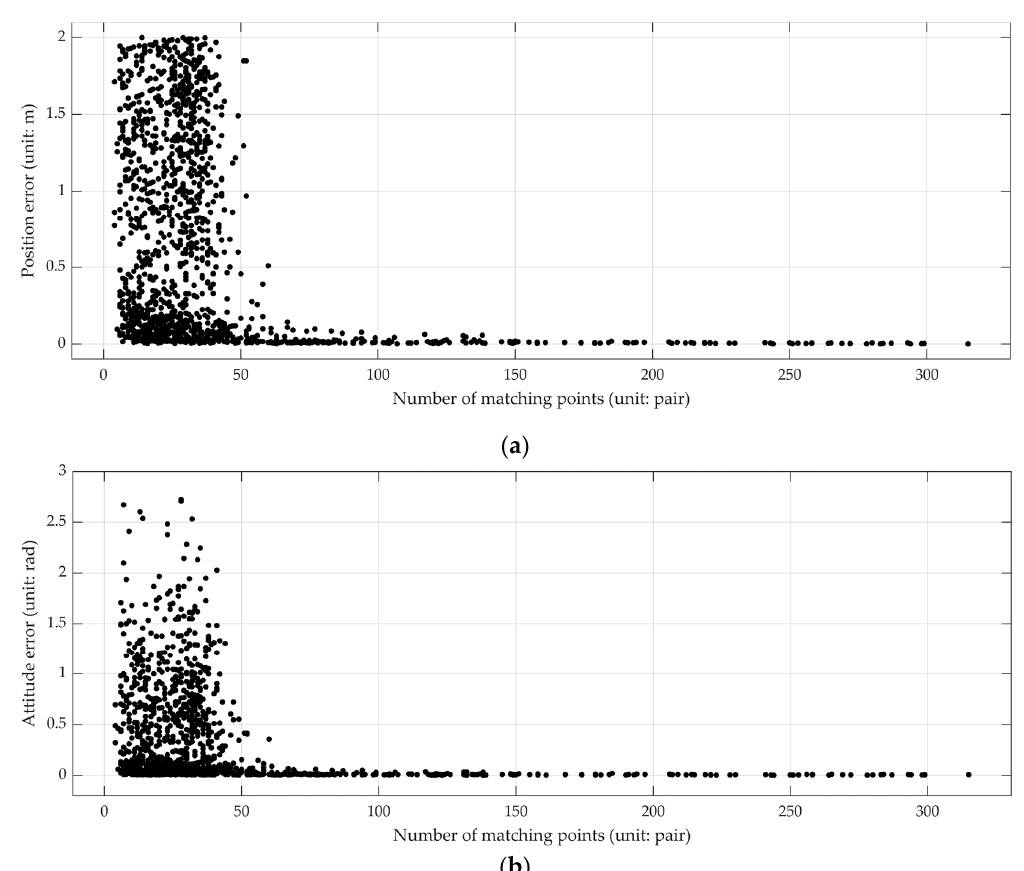
Figure 2. Relationship between pose error and corresponding number of matching points. ( a ) Position error vs. number of matching points; ( b ) attitude error vs. number of matching points.